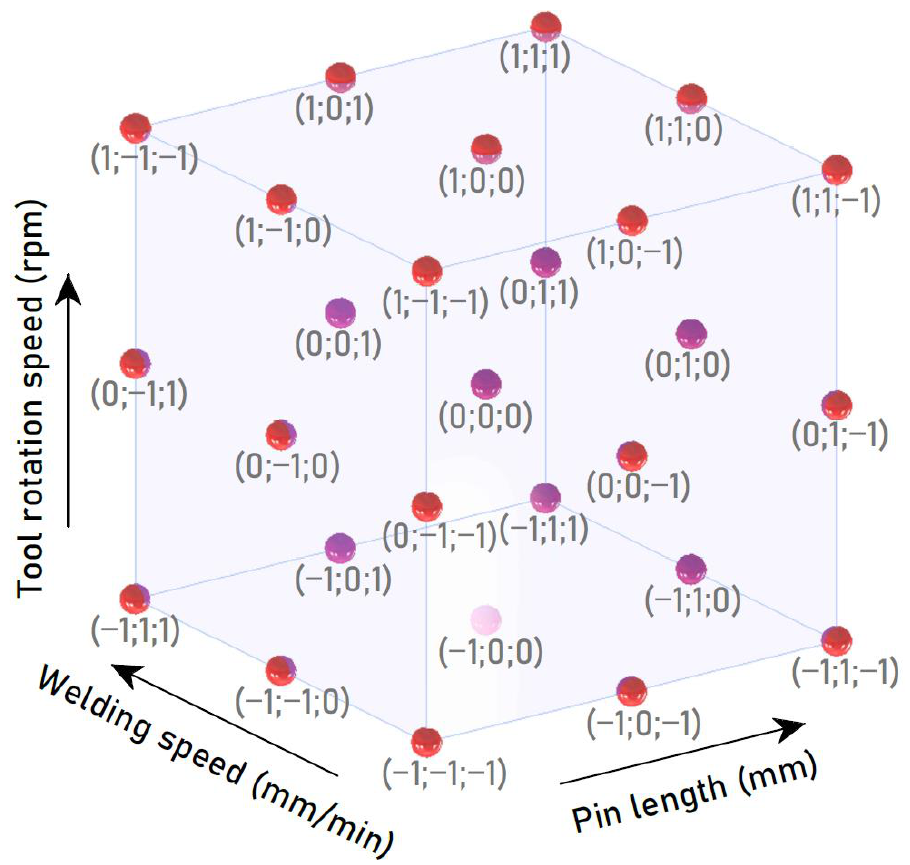
Figure 3. The 3D design space of welding parameters. Table 3. The welding parameters used in the DoE matrix assigned to the DoE level ( − 1, 0, +1). DoE Level Pin Length d, mm